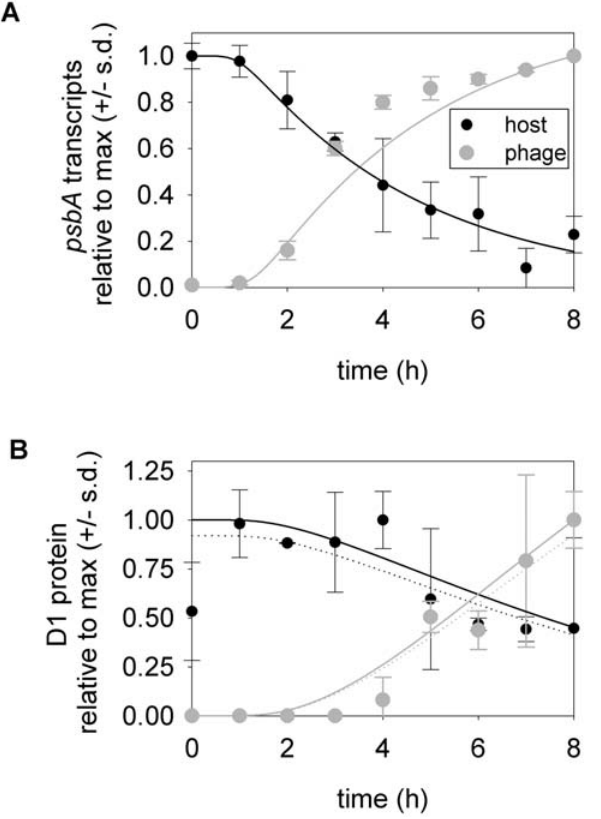
Figure 2. Measured (data points) and modeled (lines) levels of host and phage psbA transcripts (A) and D1 protein product (B) during the lytic cycle of infection of Prochlorococcus MED4 by cyanophage P-SSP7. For modeled levels of D1 protein, solid lines represent the sum of functional and damaged D1, and dotted lines represent functional D1 only. Data are from [17]. Data for host expression levels were transformed assuming that 50% of cells were infected [17].